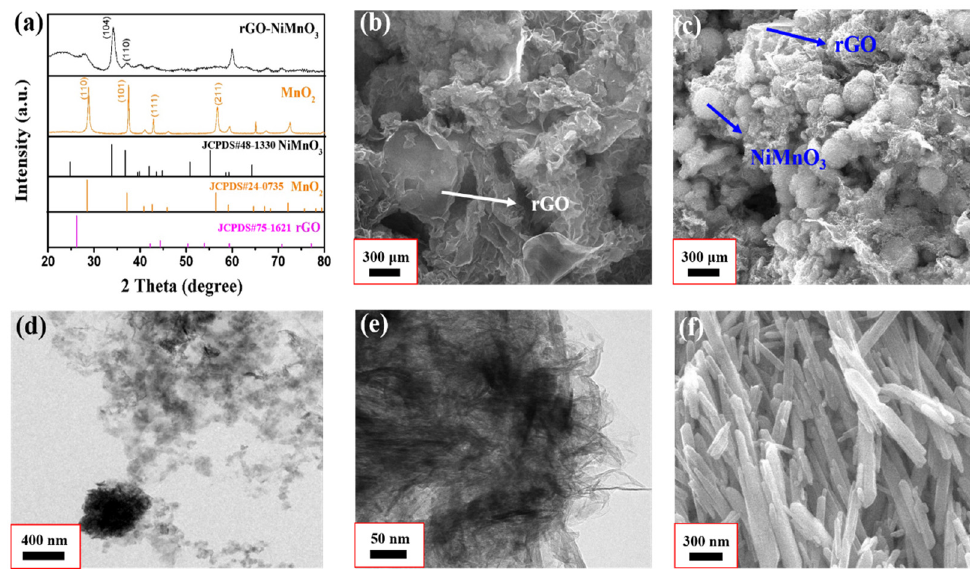
Figure 1. ( a ) XRD patterns of rGO-NiMnO 3 and MnO 2 nanowires; ( b , c ) SEM images of rGO-NiMnO 3 ; ( d , e ) TEM images of rGO-NiMnO 3 ; ( f ) SEM images of MnO 2 nanowires. Figure 1b,c is SEM images of rGO-NiMnO 3 at different scales. From Figure 1c,